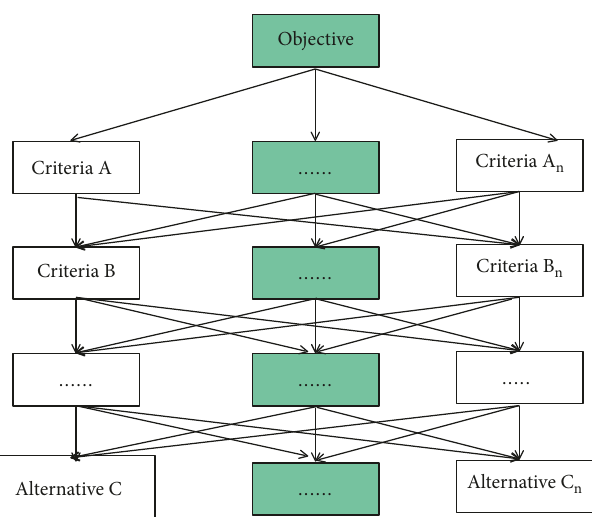
Figure 1: Hierarchical model